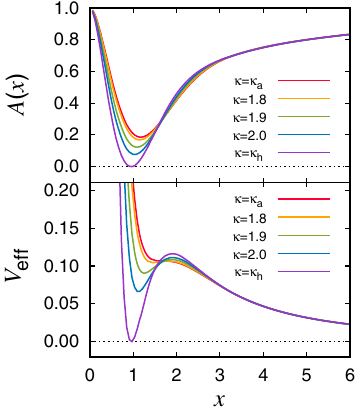
Fig. 1 A ( x ) and V eff on D a are respectively shown in the top and bottom panels where x = ( 2 m • ) − 1 r and κ = ensures the existence of its antiphoton and photon spheres for the Lee- Wick horizonless ultracompact object